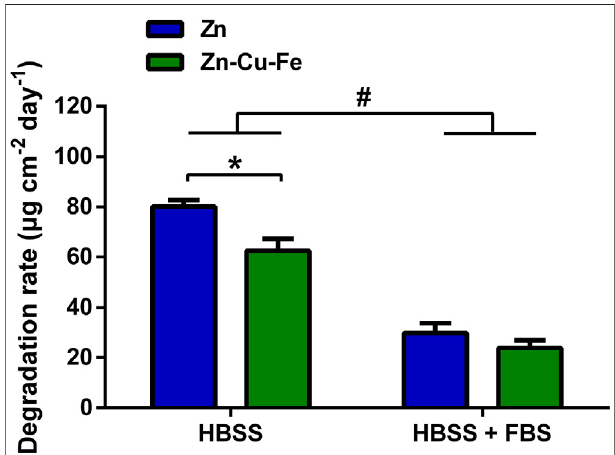
FIGURE 3 | The in vitro degradation rates of Zn and Zn-Cu-Fe were calculatedbyweightloss (n=4).Thehashtagindicates asigni fi cantdifference ( p < 0.05) between HBSS and HBSS with FBS, determined by two-way ANOVA. The asterisk represents a signi fi cant difference in Zn and Zn-